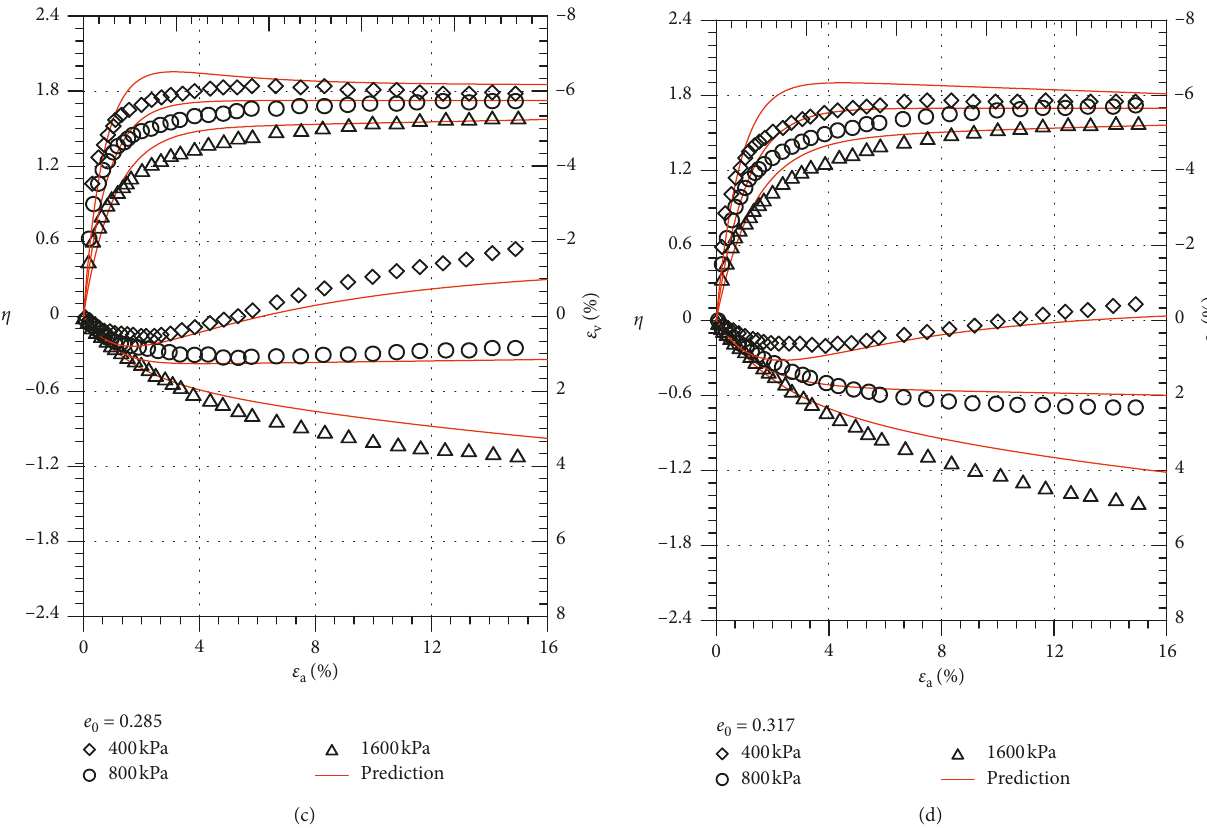
Figure 16: Experiment result and prediction of TRM with different void ratios. (a) e